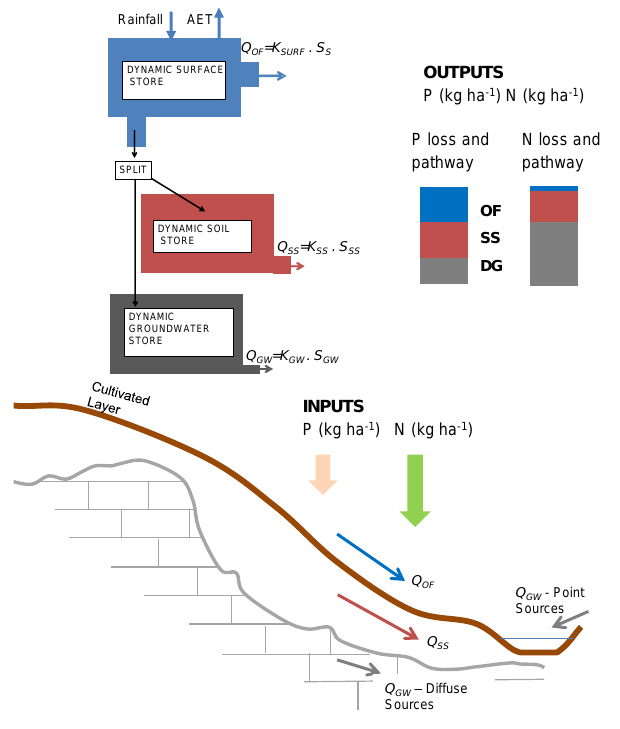
Figure 4. Conceptual diagram of CRAFT (top) and a hillslope (bot- tom), showing the dominant flow and nutrient transport